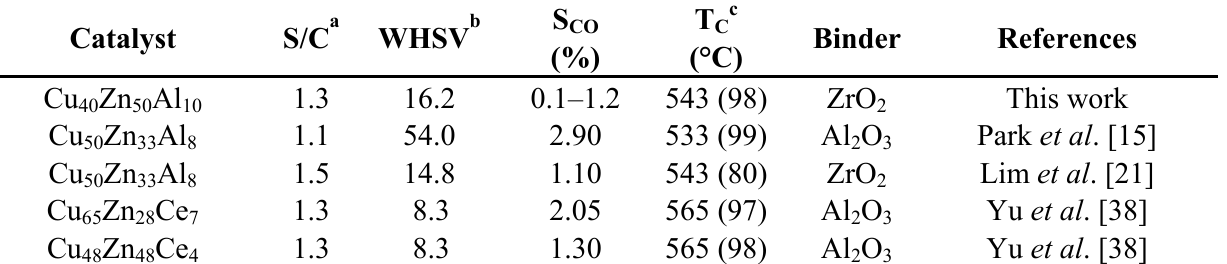
Table 5. Comparison of SRM performance over different CuO/ZnO/Al in the